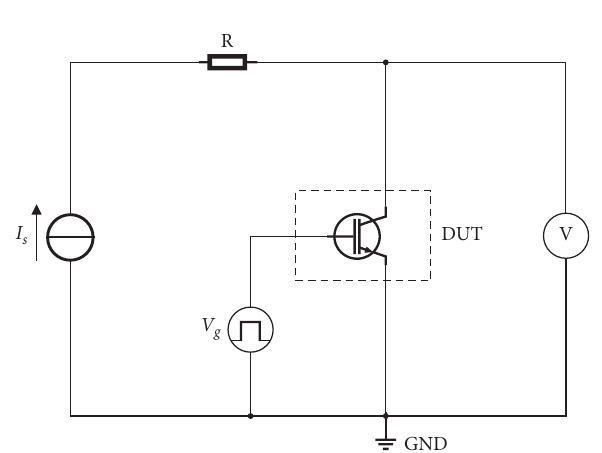
Figure 2: The simulation circuit for measuring on-state